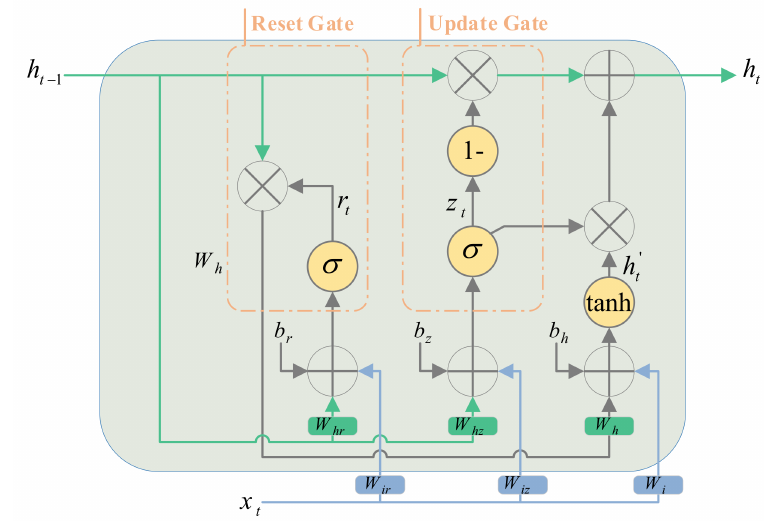
Figure 3. Illustration of GRU